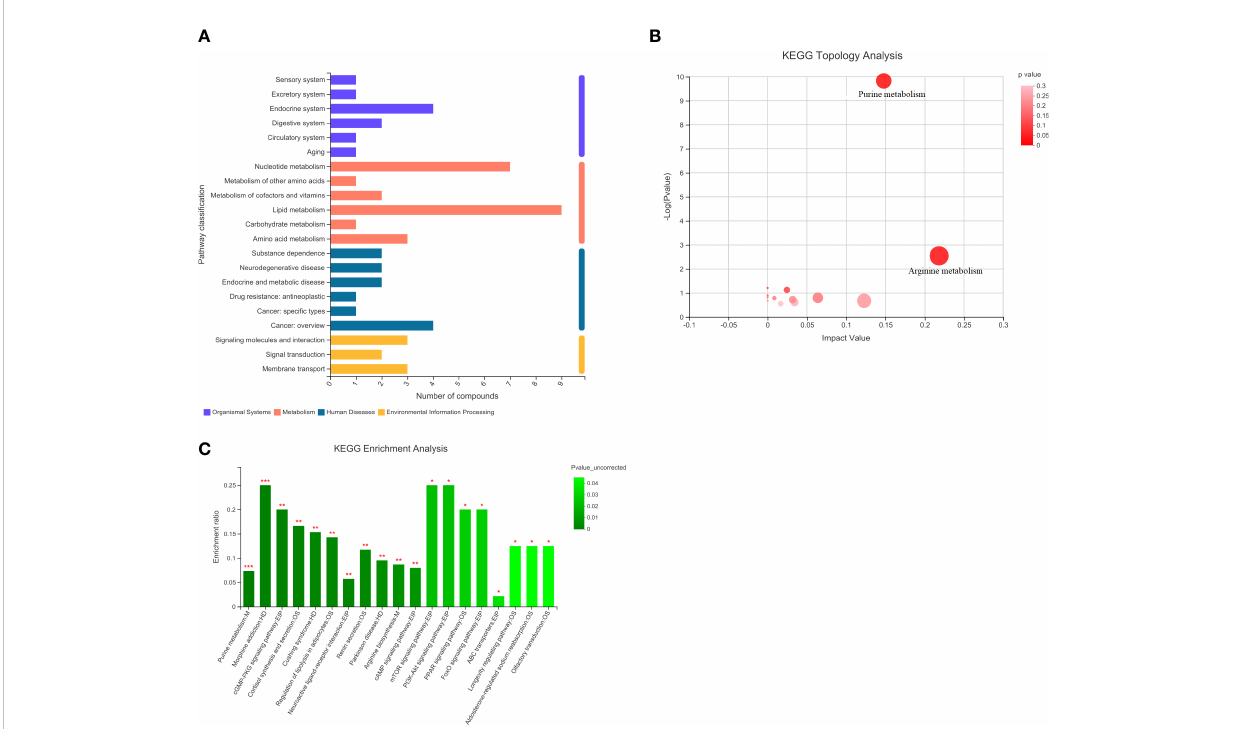
FIGURE 9 Statistical plots of differential metabolite classi fi cation, KEGG statistical plots and bubble plots of KEGG topology analysis. (A) . Categorical aggregation plot of 93 differential metabolites. Note: The vertical coordinate is the secondary classi fi cation category of the KEGG compound and the horizontal coordinate is the number of metabolites annotated to that classi fi cation. (B) . 93 differential metabolites KEGG topology analysis bubble map. Note: Each bubble in the graph represents a KEGG Pathway pathway; the horizontal axis indicates the relative importance of metabolites in the pathway in terms of Impact Value; the vertical axis indicates the enrichment signi fi cance of metabolite involvement in the pathway - log10(Pvalue); the size of the bubble represents the Impact Value value; the larger the bubble, the greater the importance of the pathway. (C) . KEGG statistical map of 93 differential metabolites. Note: The horizontal coordinate indicates the pathway name and the vertical coordinate indicates the enrichment rate, which indicates the ratio of the number of metabolites enriched in the pathway to the number of metabolites annotated to the pathway (Background number), the greater the ratio, the greater the enrichment. Column color gradients indicate the signi fi cance of enrichment, with the default color being darker, representing more signi fi cant enrichment for that KEGG term, where Pvalue or FDR < 0.001 is marked as ***, Pvalue or FDR < 0.01 is marked as **, and Pvalue or FDR < 0.05 is marked as